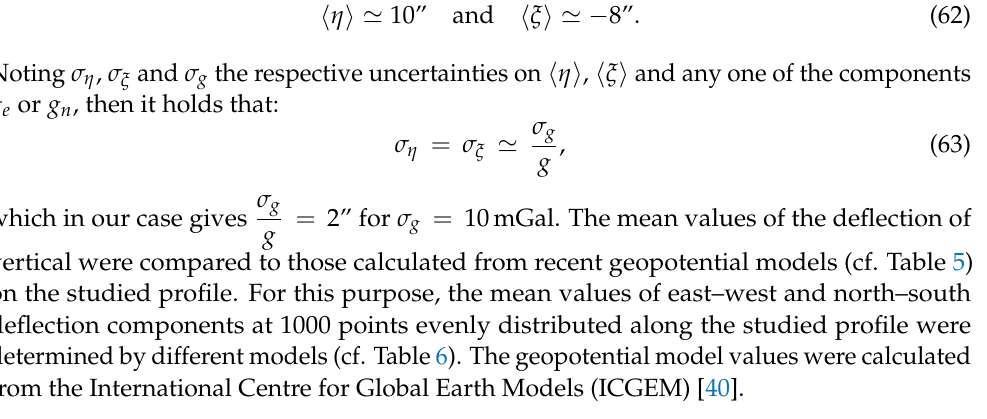
Table 5. Properties of recent global gravity field models used to calculate estimates of the vertical deflection components on the study profile. The column entitled Data indicates by specific letters which datasets have been used to compute the geopotential model in question, i.e., A for satellite altimetry data, S for satellite gravity data (GRACE, GOCE, LAGEOS), G for ground data (terrestrial, shipborne and airborne gravity measurements) and T for topography data. The letter M represents a model that derives from a previous model taken as an a priori. The first two models (no 1 and no 2) calculated from satellite data only have a spatial resolution of 67 km. The last two (no 3 and no 4) assimilate a wide variety of gravity data, which allows for a finer spatial resolution of 9 km. Model